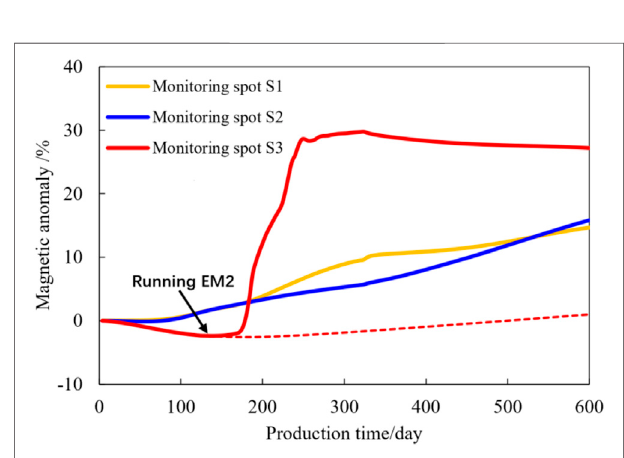
FIGURE 13 | Magnetic anomaly curves of monitoring spots located in different region when apply EM2.